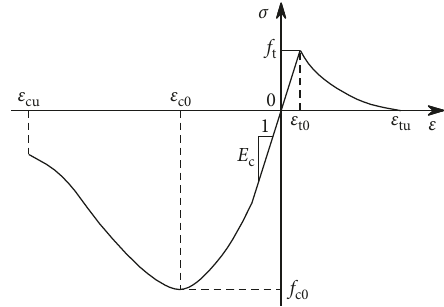
Figure 8: Constitutive relationship of steel.